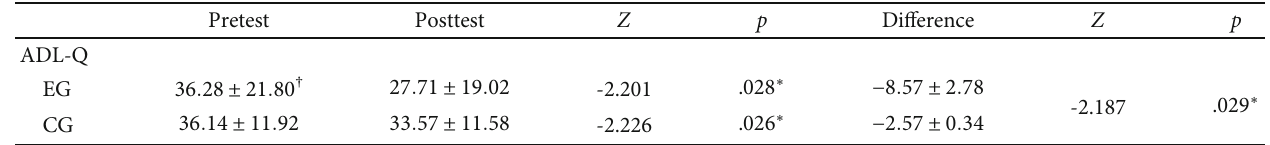
Table 5: Changes of the New ADL Questionnaire before and after intervention ( N = 14 ).